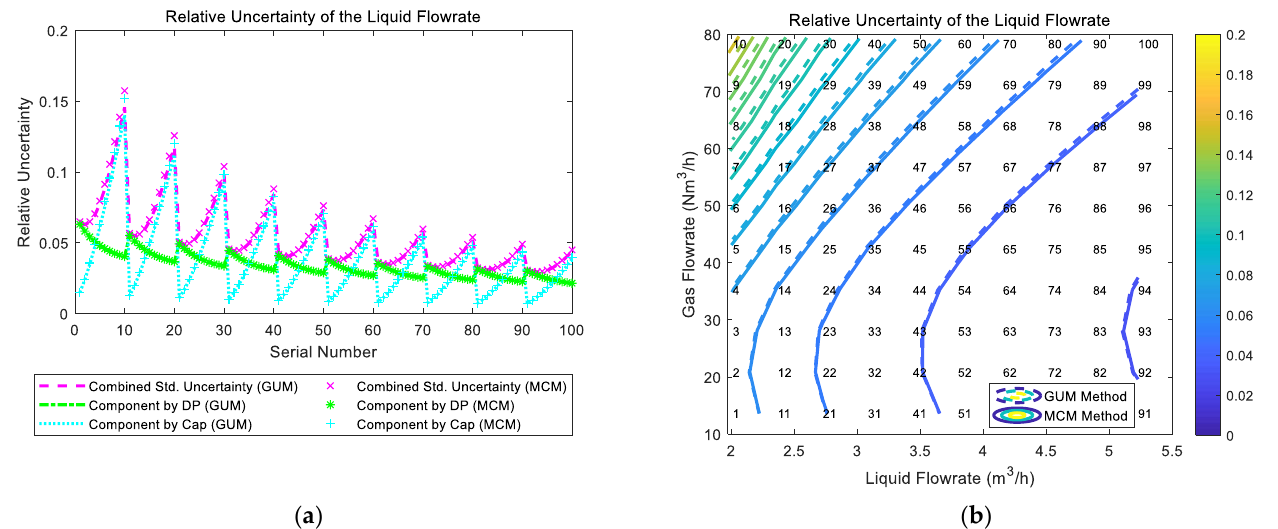
Figure 11. The composition and distribution of the relative uncertainty of the liquid flowrate of the “DP + Cap” method : ( a ) composition diagram; ( b ) distribution diagram. (Each contour line denotes an increment of uncertainty of 0.01. More information about the composition and distribution can be found in Section 2.4.1).